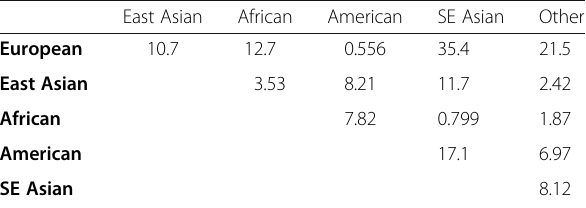
Table 4 Chi-square analysis of BTNL8-BTNL3 deletions in the general